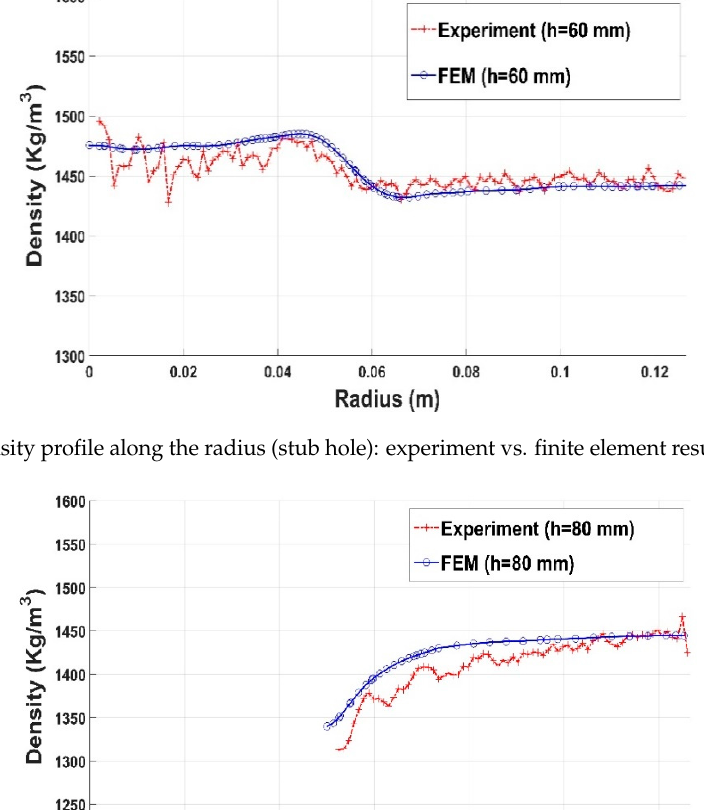
Figure 26. Density profile along the radius (stub hole): experiment vs. finite element result (h = 40 mm).